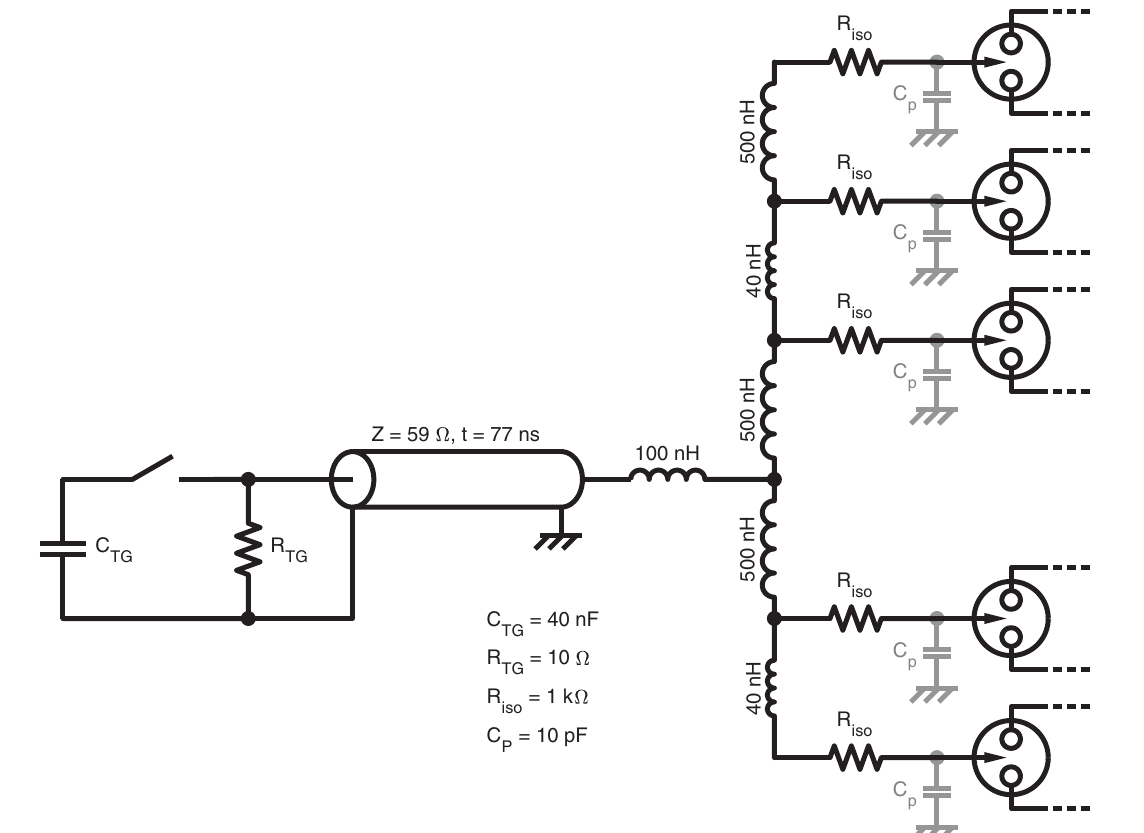
FIG. 4. Conventional LTD trigger circuit using aqueous resistors ( R